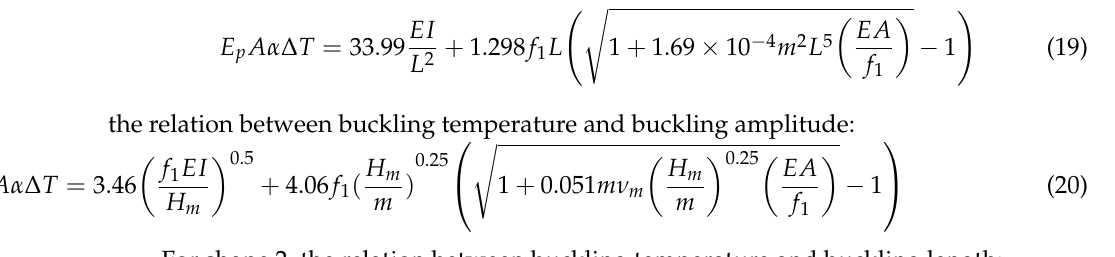
Figure 7. Idealised shapes ( a ). Shape 1 and ( b ) Shape 2, used in the analytical study [31]. For shape 1, the relation between buckling temperature and buckling length: